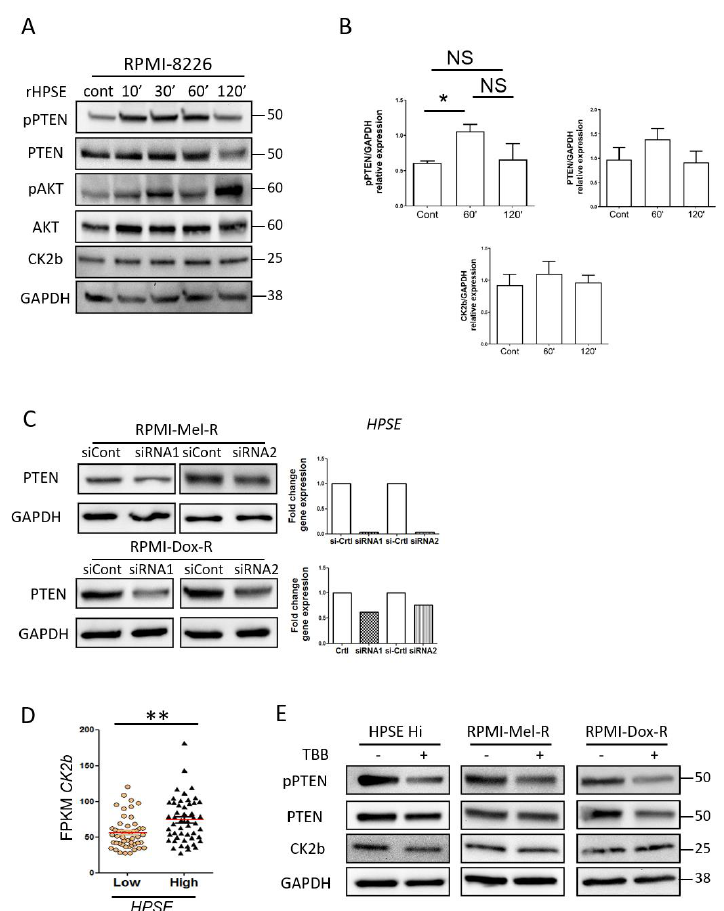
Figure 5. Heparanase increases PTEN phosphorylation through CK2 and promotes PTEN protein stability and inactivity. ( A ) RPMI-8226 control cells were treated with 1 ug / mL of recombinant heparanase (rHPSE) for the indicated time and pPTEN, PTEN, p-AKT, AKT and CK2b protein expression were investigated by Western blot. ( B ) Quantification of Western blot shown in panel A corresponding to the relative expression of pPTEN, PTEN and CK2b normalized with GAPDH expression, from three independent experiments. * p < 0.05 by one tailed Mann Whitney test. ( C ) RPMI-Mel-R and RPMI-Dox-R were transfected with siRNA control (siCont) or with two non-overlapping siRNAs to silence HPSE and PTEN level evaluated by Western blot. Right panel, HPSE silencing was evaluated by RT-PCR. ( D ) CK2b levels present in HPSE-high and HPSE-low patient groups. ** p < 0.01 by one-tailed, unpaired t -test. ( E ) CAG HPSE Hi and melphalan-resistant (Mel-R) and doxycycline-resistant (Dox-R) RMPI-8226 cell lines were incubated with CK2 inhibitor TBB for 6 h and Western blots performed to assess levels of pPTEN, PTEN and